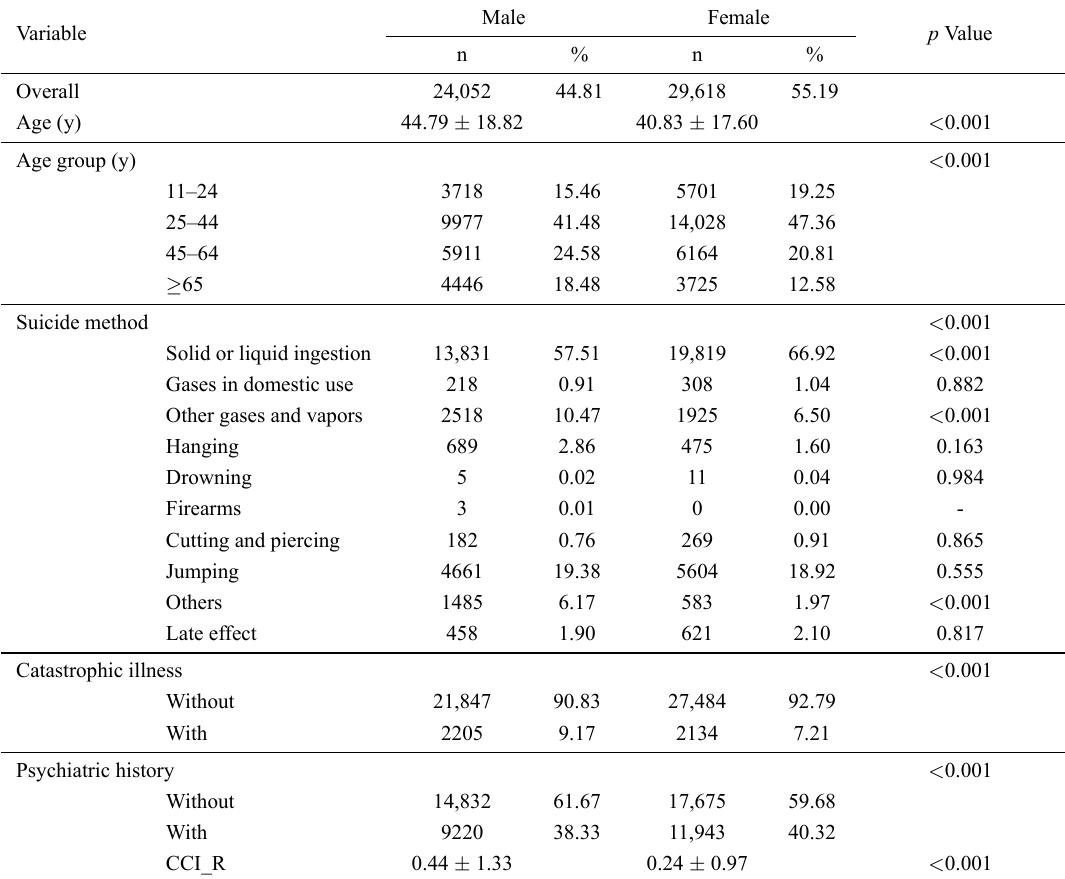
Table 1. Gender difference among suicide